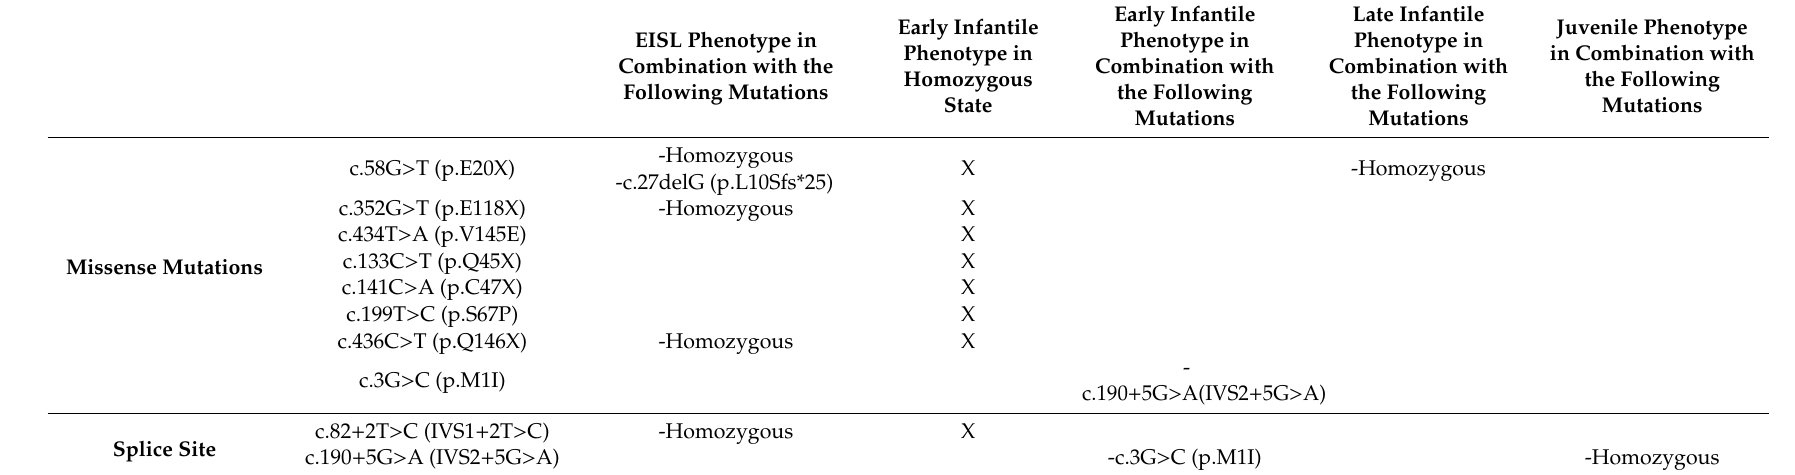
Table 6. NPC2 mutations causing early infantile phenotype. Mutation–phenotype